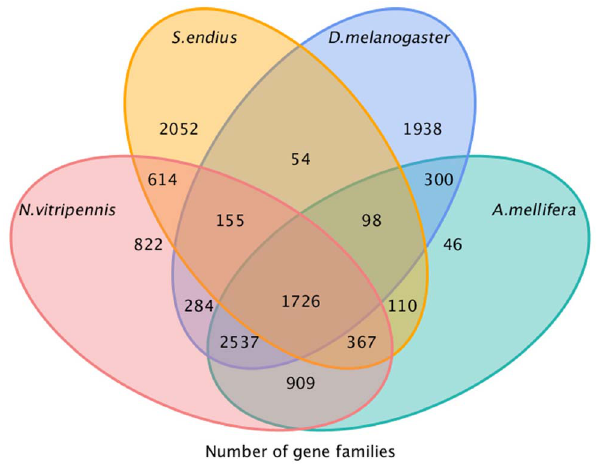
Figure 2. Summary of gene family classification among four species, S.endius , N.vitripennis , A.florea and D.melanogaster